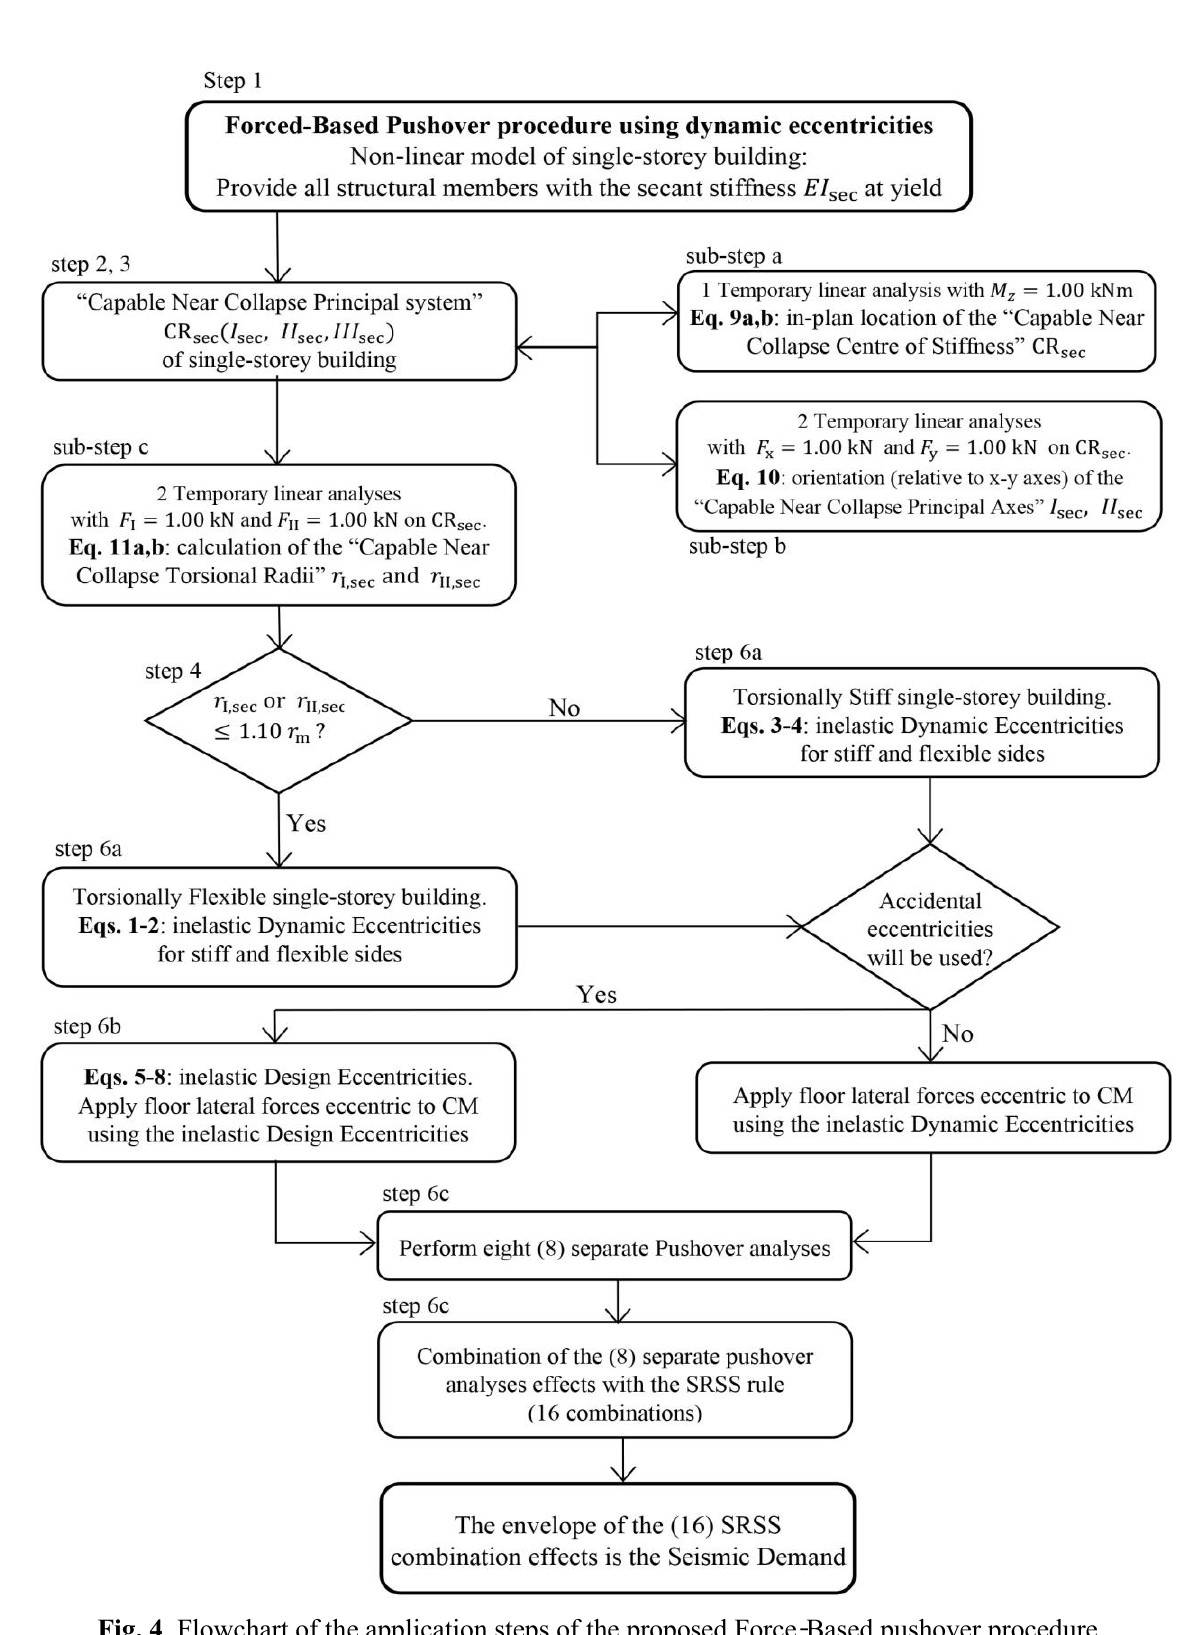
Fig. 4 . Flowchart of the application steps of the proposed Force-Based pushover